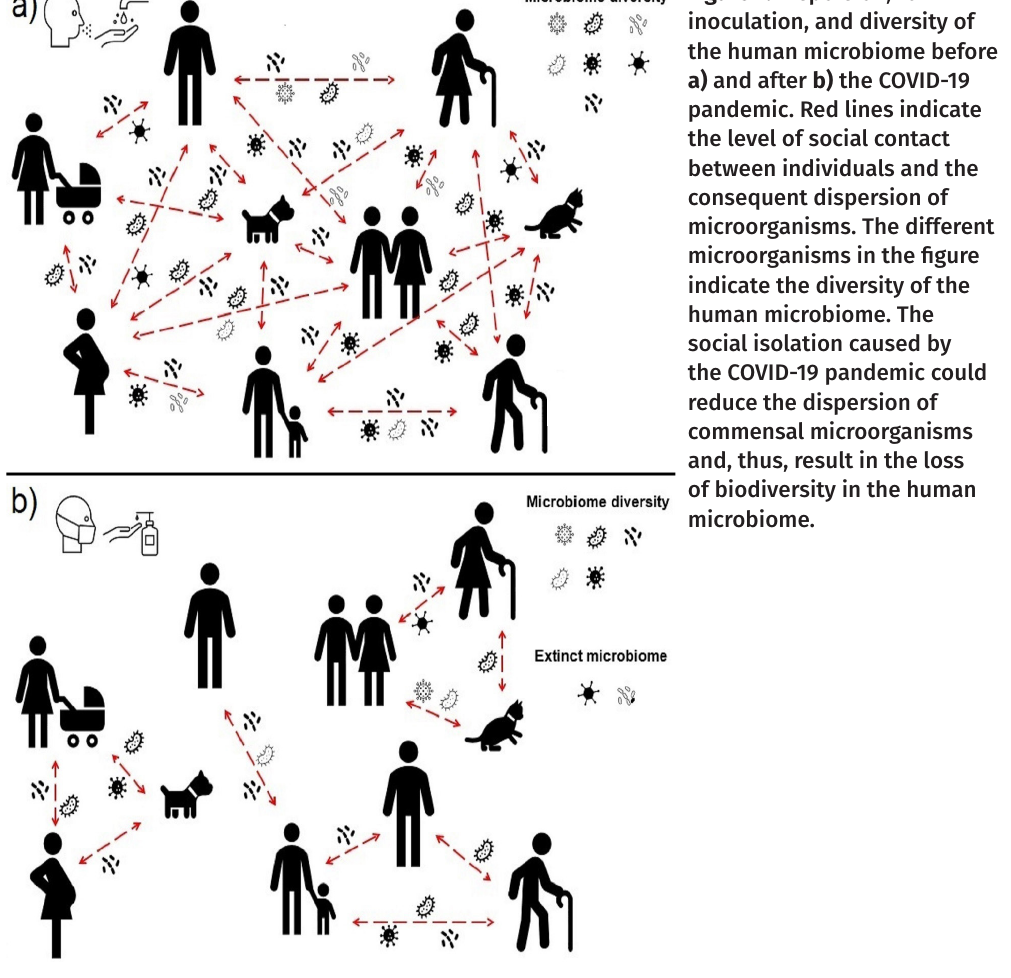
Figure 1. Dispersion, re- inoculation, and diversity of the human microbiome before a) and after b) the COVID-19 pandemic. Red lines indicate the level of social contact between individuals and the consequent dispersion of microorganisms. The different microorganisms in the figure indicate the diversity of the human microbiome. The social isolation caused by the COVID-19 pandemic could reduce the dispersion of commensal microorganisms and, thus, result in the loss of biodiversity in the human